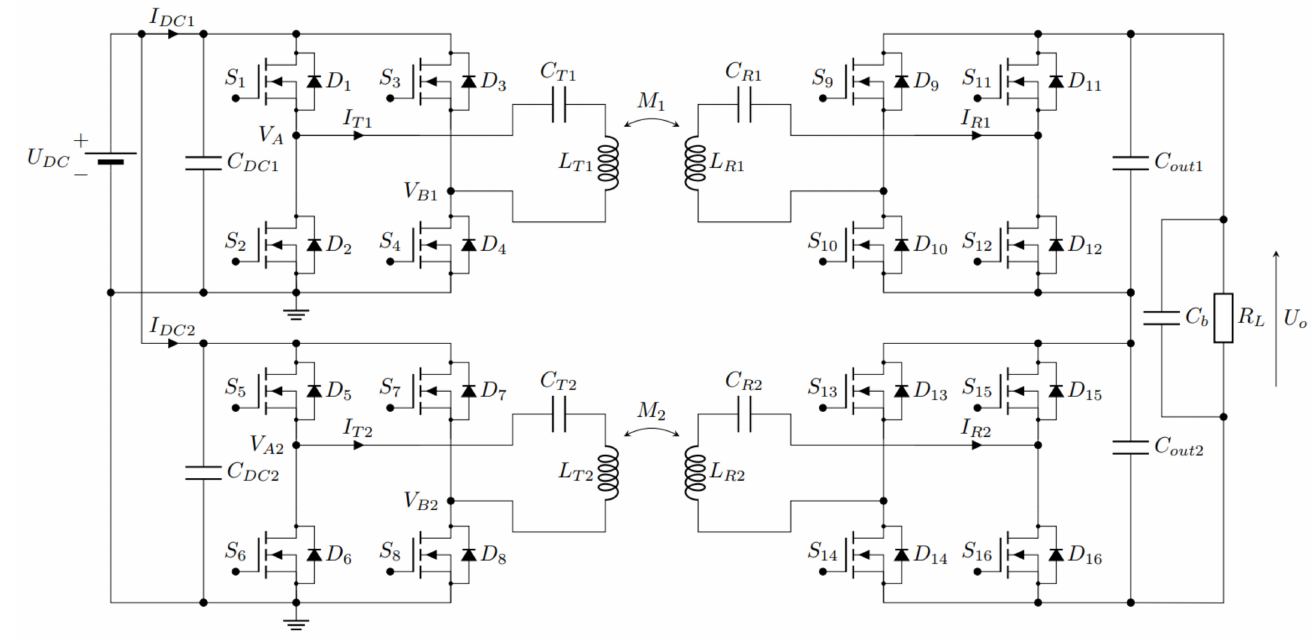
Figure 2. The IPT inverter structure using a double DD coil